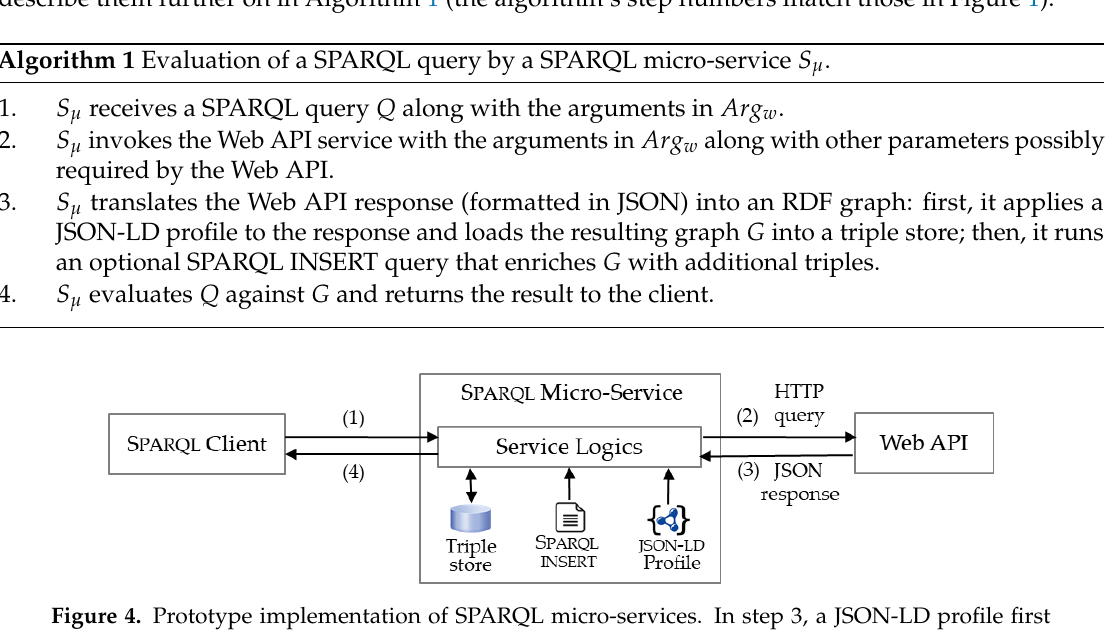
Figure 4. Prototype implementation of SPARQL micro-services. In step 3, a JSON-LD profile